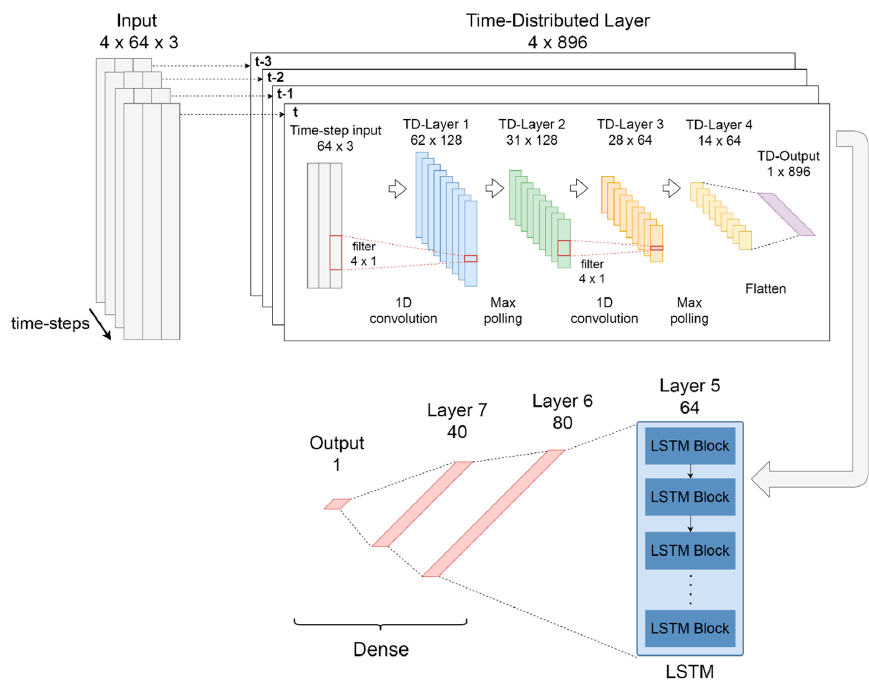
Figure 4. Deep neural networks with convolutional and long short-term memory (LSTM) layers